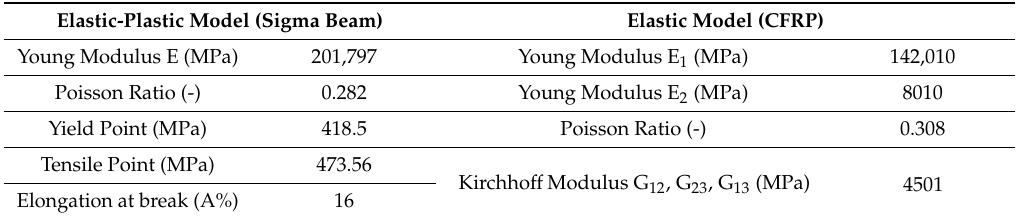
Table 3. Material properties of Sigma Beam and CFRP.